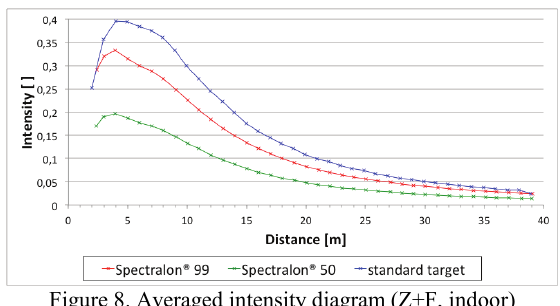
Figure 8. Averaged intensity diagram (Z+F, indoor)